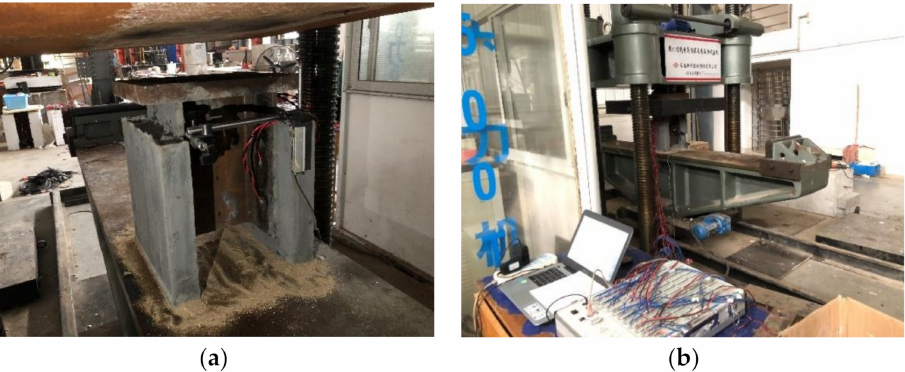
Figure 2. Static loading device: ( a ) Push-out specimen; ( b ) Specimen